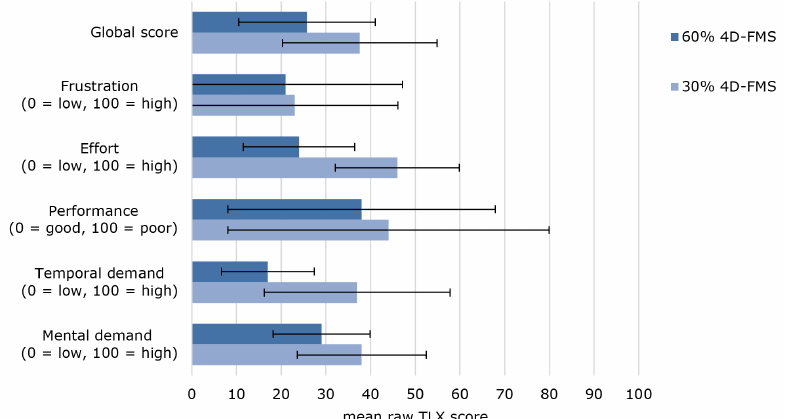
Figure 11. Mean raw TLX scores for the scenarios (S30 vs. S60 vs. S80). Error bars represent standard deviations.